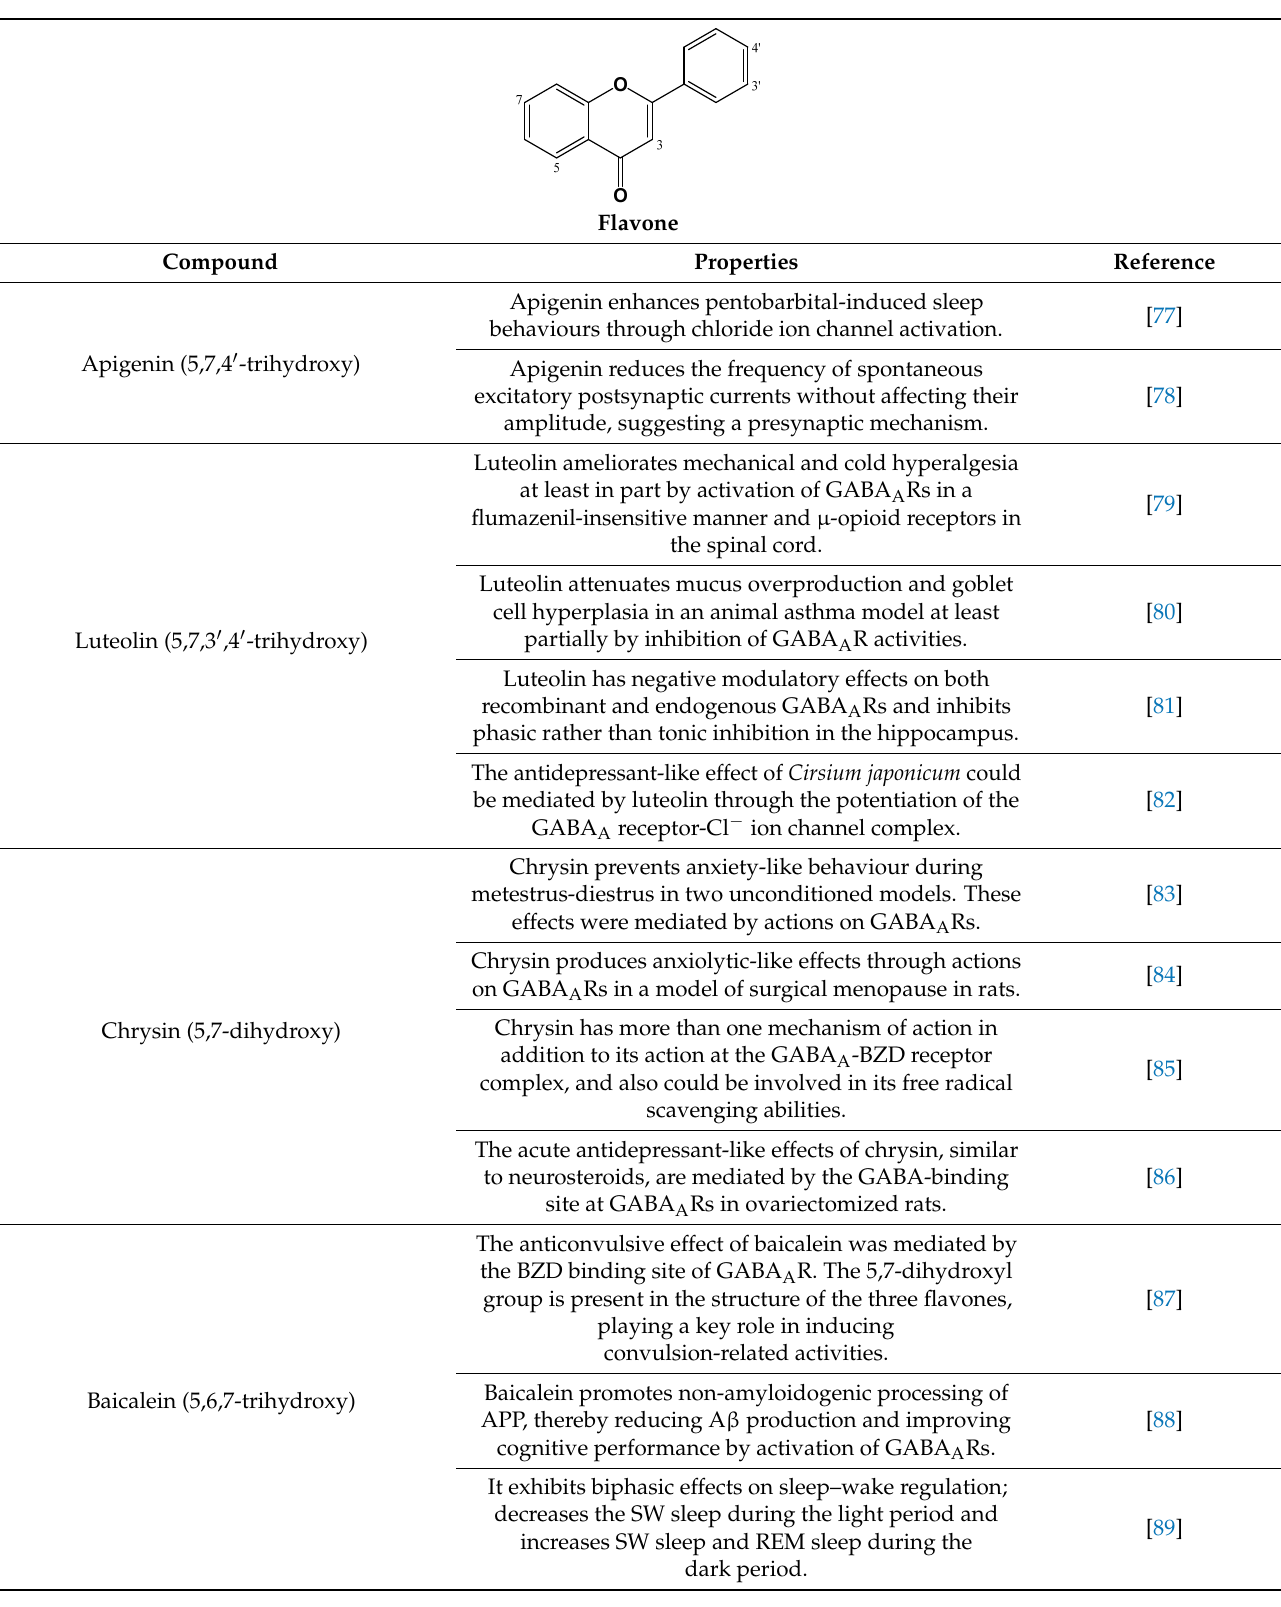
Table 2. Flavones with relevant GABAergic effects. A β ( β -amyloid), APP (amyloid precursor protein), EPM (elevated plus-maze), HSP70 (heat shock protein-70), MAPK (mitogen-activated protein kinase), REM (rapid eye movement), SW (slow wave).